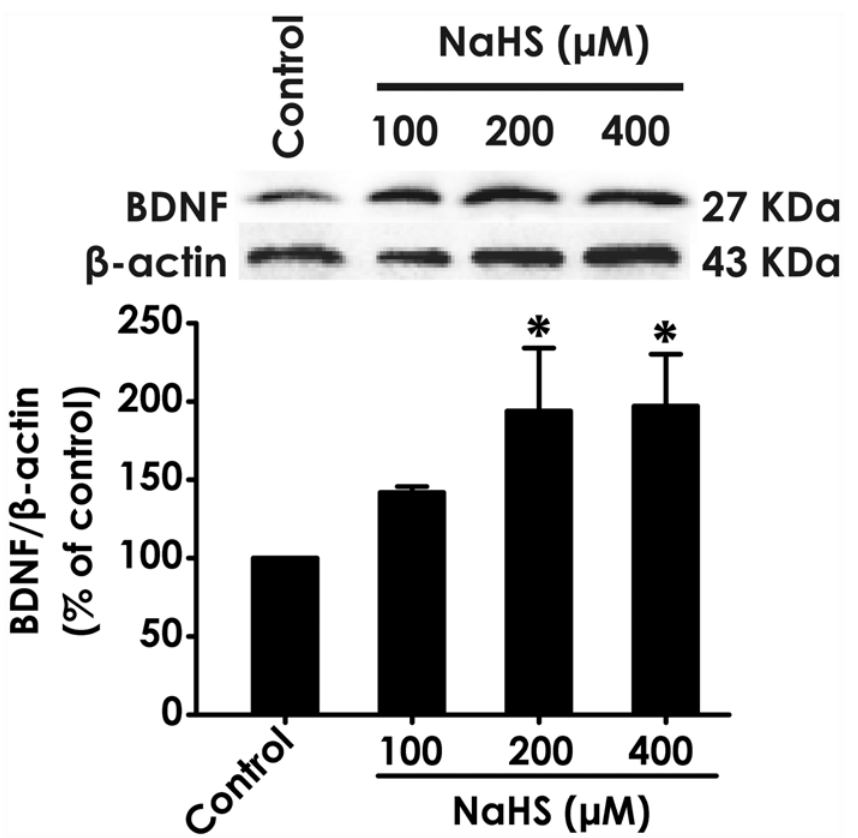
Fig 1. Effect of H 2 S on the expression of BDNF protein in PC12 cells. PC12 cells were treated with NaHS (100, 200, and 400 μ M) for 24 h. The expression of BDNF protein was determined by Western blot using anti- BDNF antibody, and β -actin was used as a loading control. The ratio of BDNF to β -actin is normalized by the value in control group. Values are expressed as the mean ± S.E.M. of three independent experiments. * P < 0.05, versus control